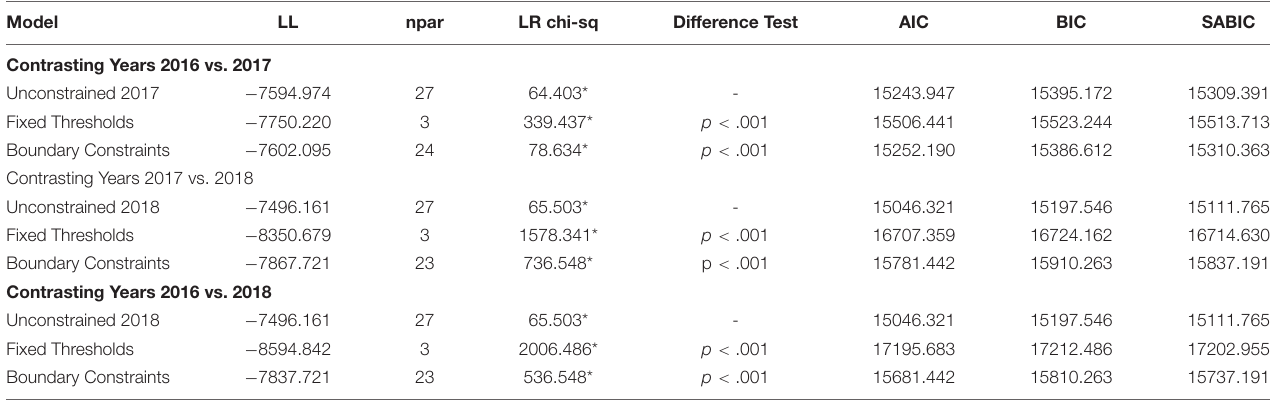
TABLE 4 | Measurement invariance of latent class solutions across years.